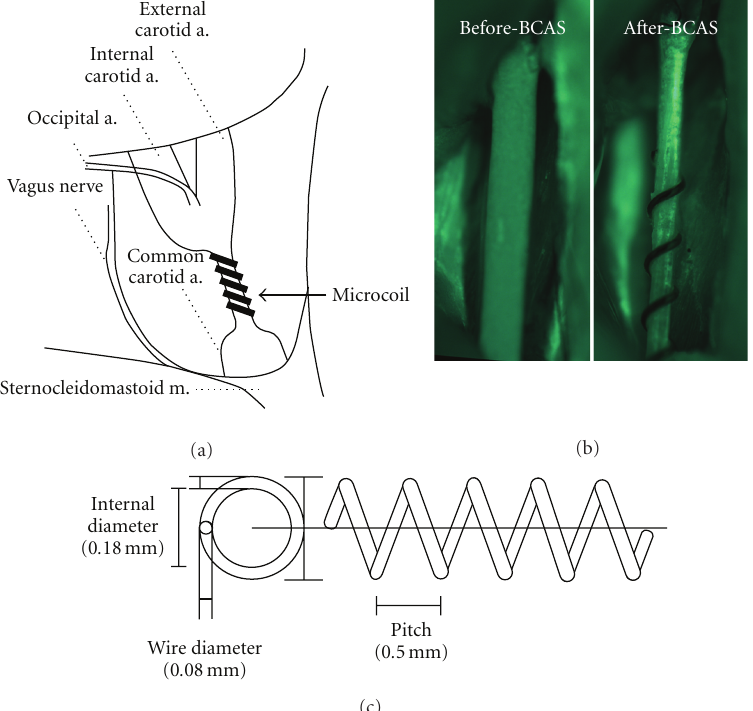
Figure 1: The procedure for BCAS and the microcoil. The microcoil is twined by rotating it around the CCA just proximal to the carotid bifurcation of a C57BL/6J mouse (a). Representative photographs of a FITC-perfused common carotid artery before (left) and after (right) placement of a microcoil (b). The microcoil is made from piano wire (wire diameter of 0.08 mm) with an inner diameter of 0.18 mm, pitch 0.50mm, and total length 2.5 mm